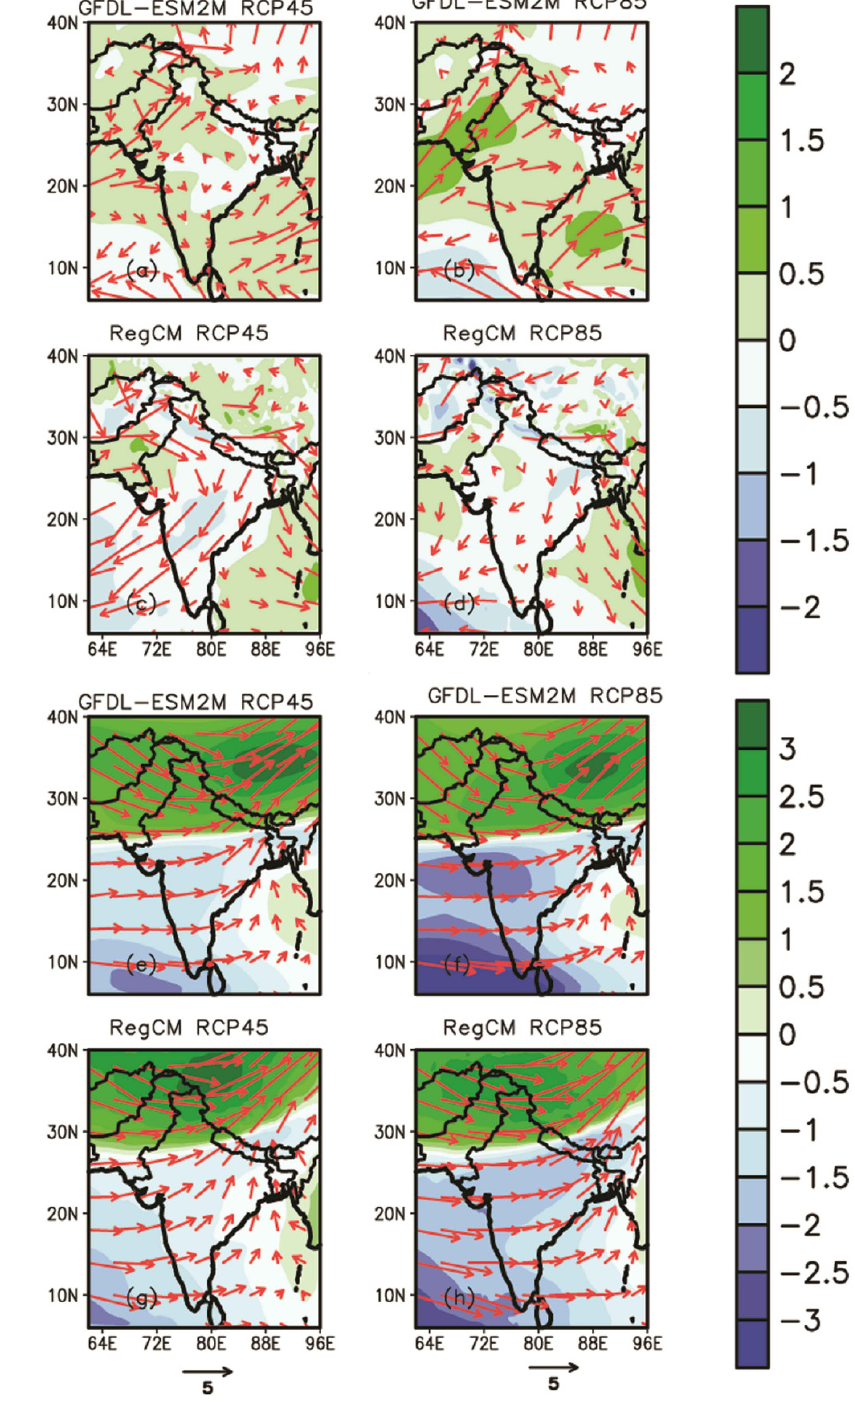
Figure 10. Projected changes (2070–2099 minus 1976–2005) in SASM mean wind speed (shading, m/s) and direction (arrows) at 850 hpa for ( a , b ) GFDL − ESM2M (RCP45 and 85); ( c , d ) RegCM4 (RCP4.5 and 8.5) and at 200 hpa for ( e , f ) GFDL − ESM2M (RCP4.5 and RCP8.5); and ( g , h ) RegCM4 (RCP4.5 and